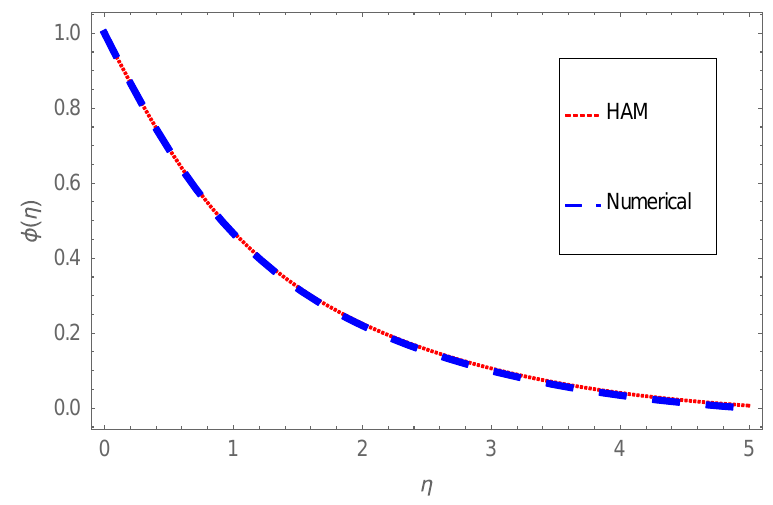
Figure 4. Dual solution for concentration field.